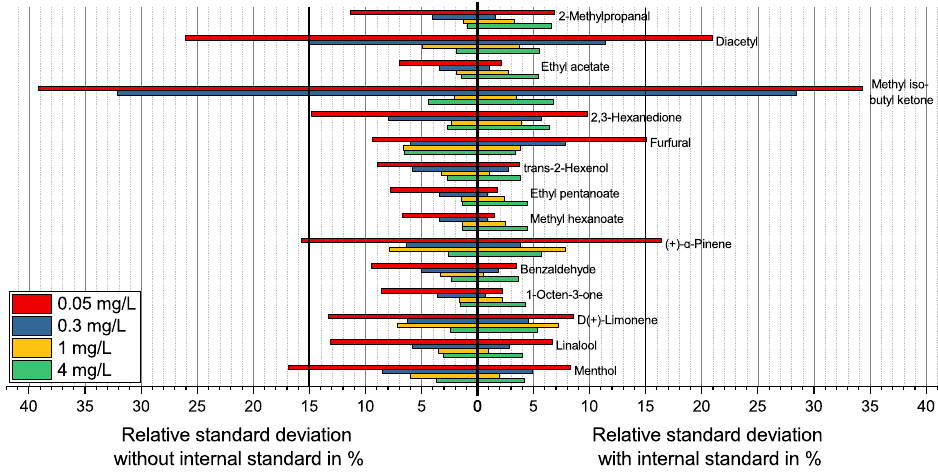
Figure 4. Diagram comparing the coefficient of variance or relative standard deviation of the signal intensity for selected standard substances in a flavorless e-liquid at four different concentration levels and eleven measurements each, with or without the use of an internal standard to reduce matrix